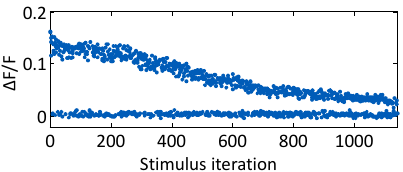
Figure 4. Evoked fluorescence decays due to photobleaching. The progression of the relative light exposure. fluorescence change, ∆ F/F, is shown across an experiment. A set of 1140 stimuli were applied in random order that spanned the stimulus pulse parameter space. Some of the stimuli evoked action potentials and others did not. The measured ∆ F/F, plotted at each stimulus iteration, decays with each light